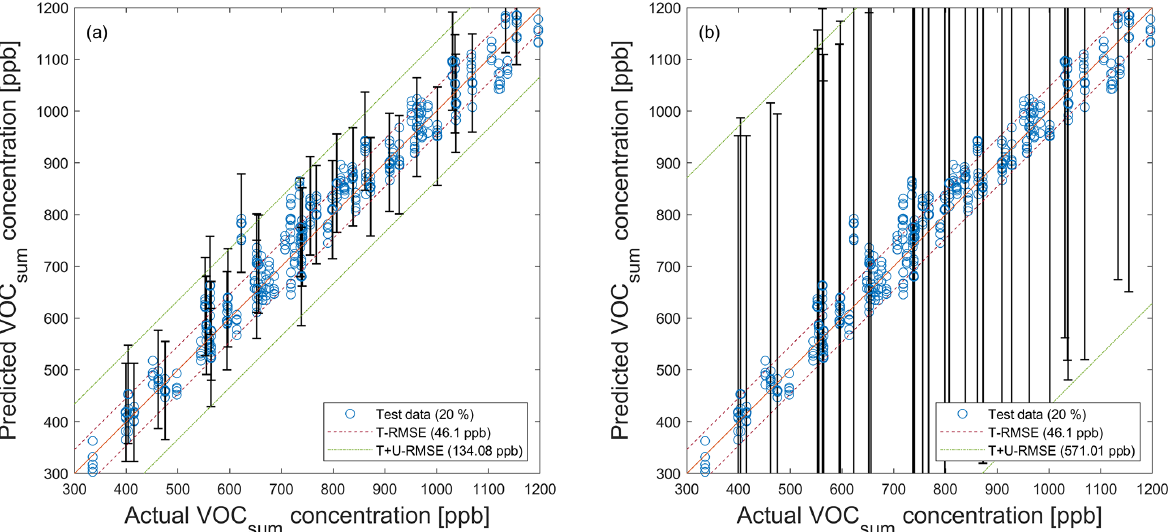
Figure A6. PLSR model (trained with raw data; n comp = 20) applied to test data (see Fig. 5) for the quantification of VOC sum and propagated uncertainty. (a) SNR = 55dB. (b) SNR = 40dB. Dashed red and green lines indicate the test RMSE (T − RMSE) and the test plus uncertainty RMSE (T + U − RMSE) based on test data, respectively. For better visibility, error bars are only shown for every 10th